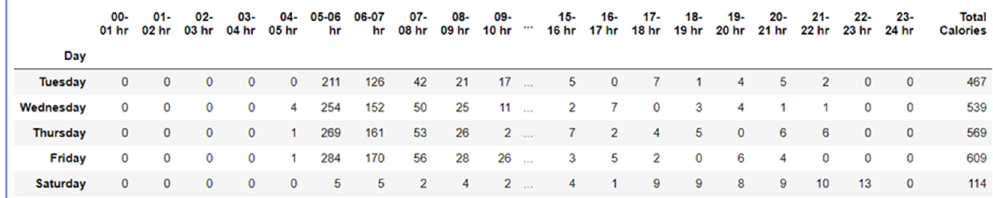
Figure 6. Sample of contextual features dataset (for Total Calories).